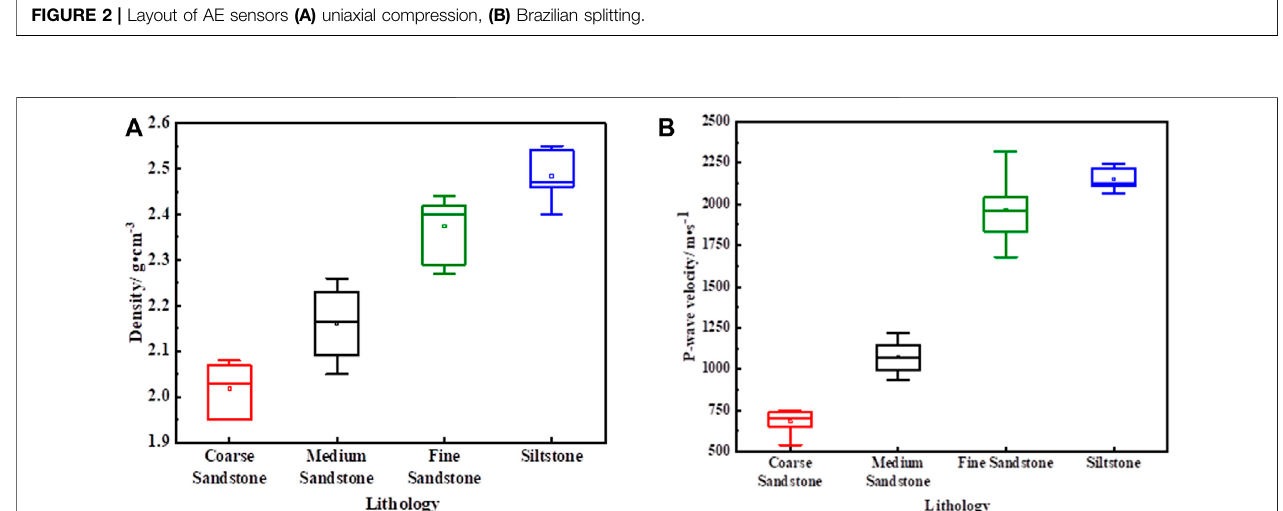
FIGURE 3 | Distribution of density and P-wave velocity for sandstone with different grain sizes (A) density, (B) P-wave velocity.